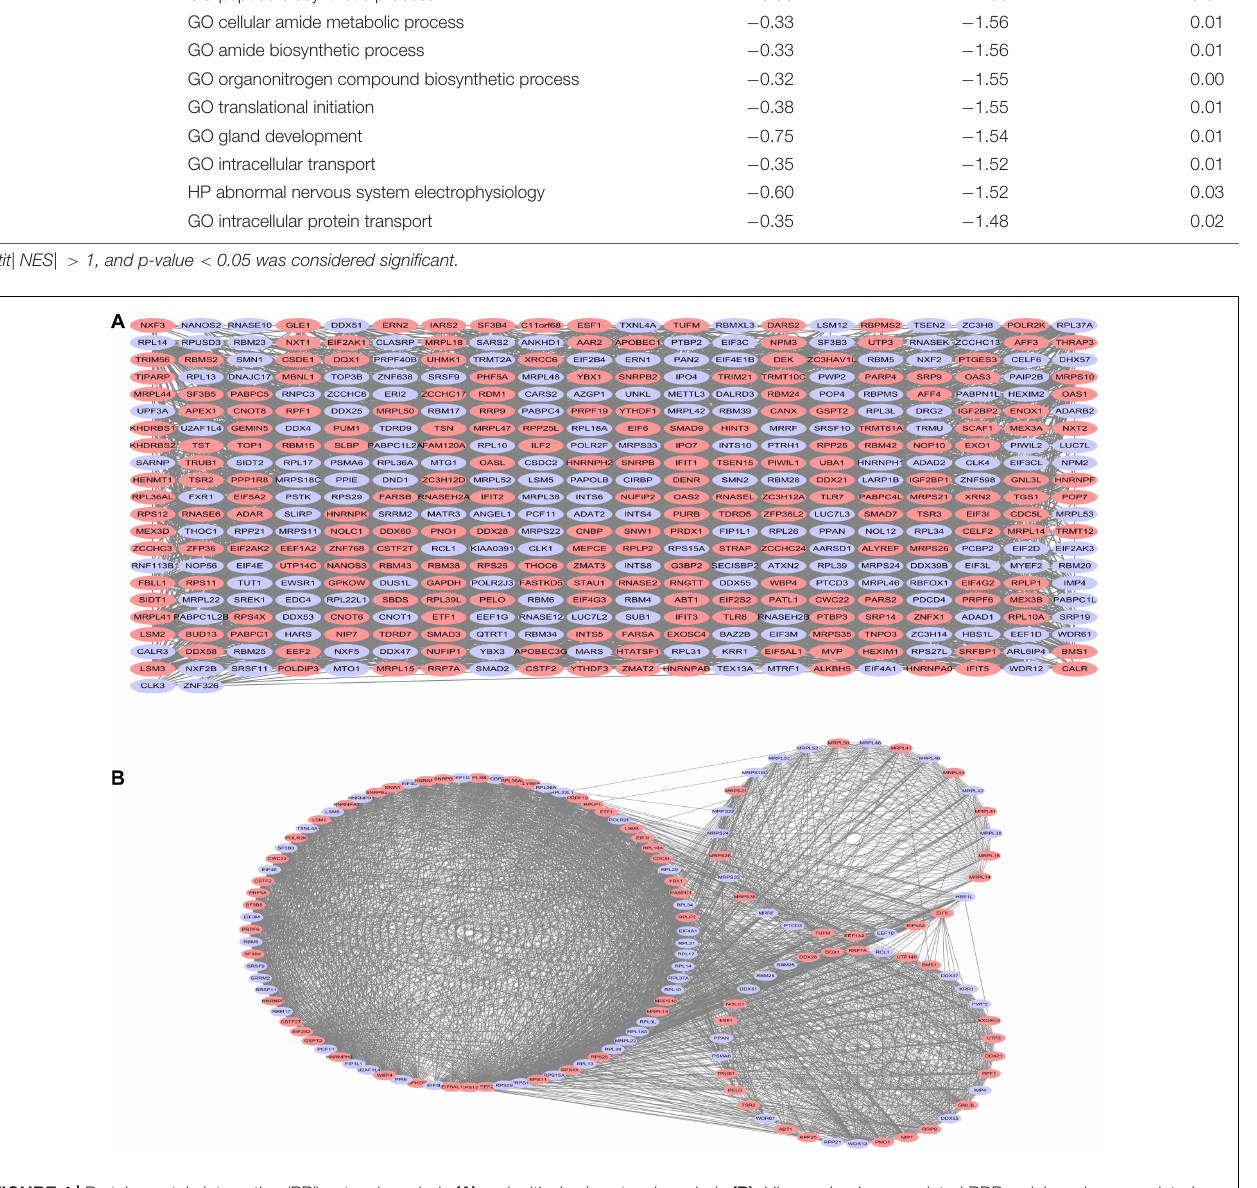
curves indicated that higher risk score was especially relevant to poor prognosis ( p = 1.196e-06); the validation cohort got the same conclusion ( p = 3.747e-03) ( Figures 6A,B ). ROC curves